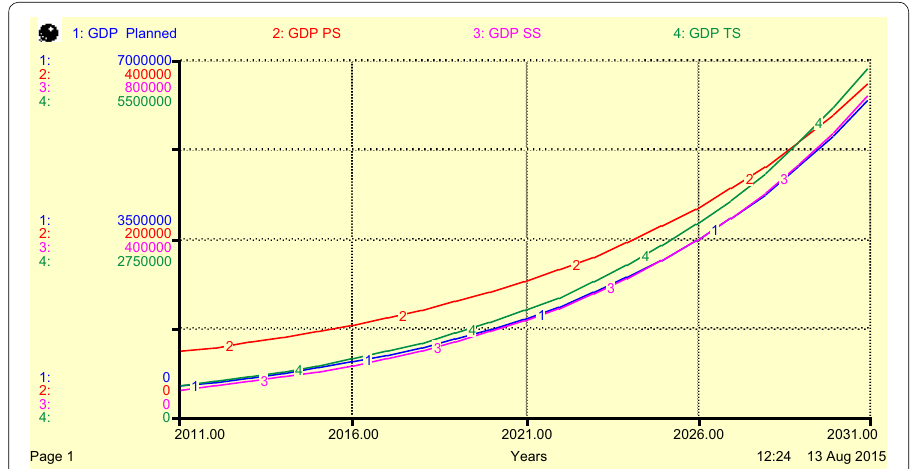
Fig. 15 Projected GDP, GDP in Primary Sector, GDP in Secondary Sector, and GDP in Tertiary Sector up to year